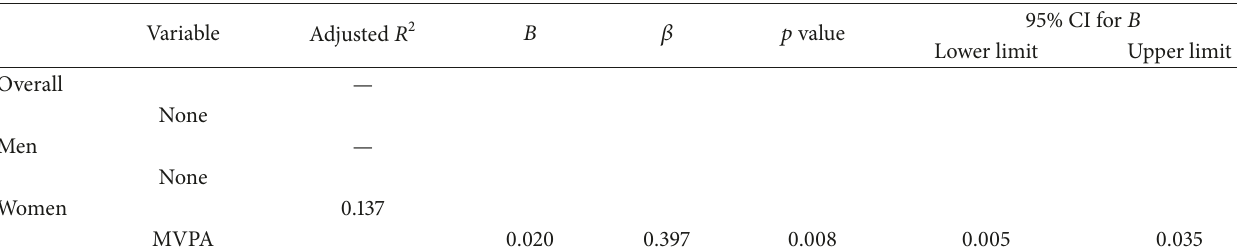
Table 3: Results of multiple regression analysis with CPM response as a dependent variable.